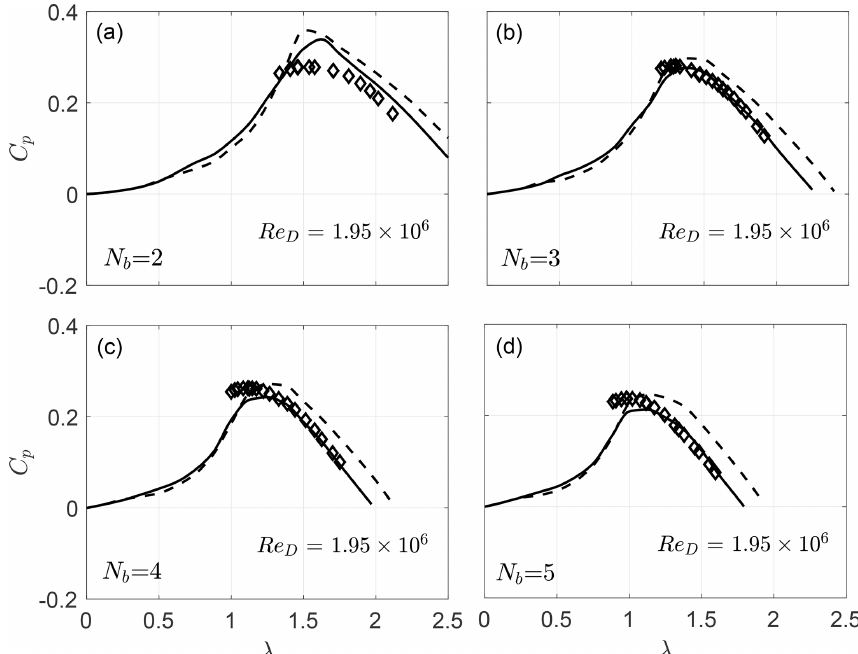
Figure 9. Measured (diamonds) and predicted (current model: solid lines; conventional model: dashed lines) power coefficients, C p , for four VAWT configurations N b = 2 , 3 , 4 , 5 and at constant Re D = 1 . 95 × 10 6 .